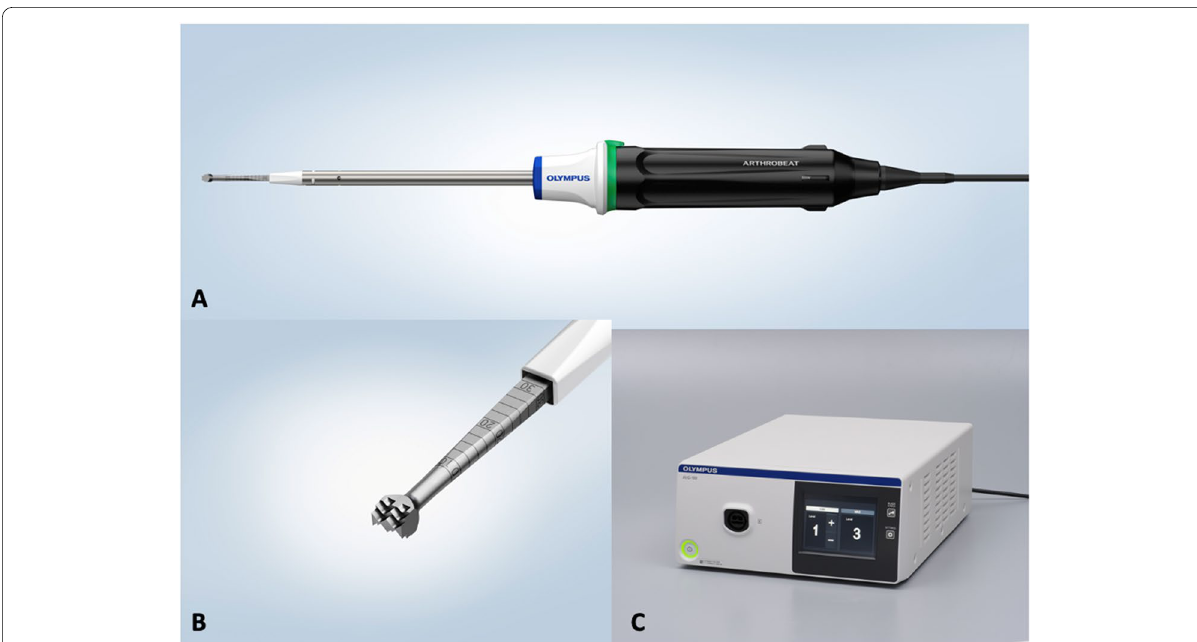
Fig. 1 Arthrobeat ultrasound device. A : Arthrobeat Transducer; B : Arthrobeat 4